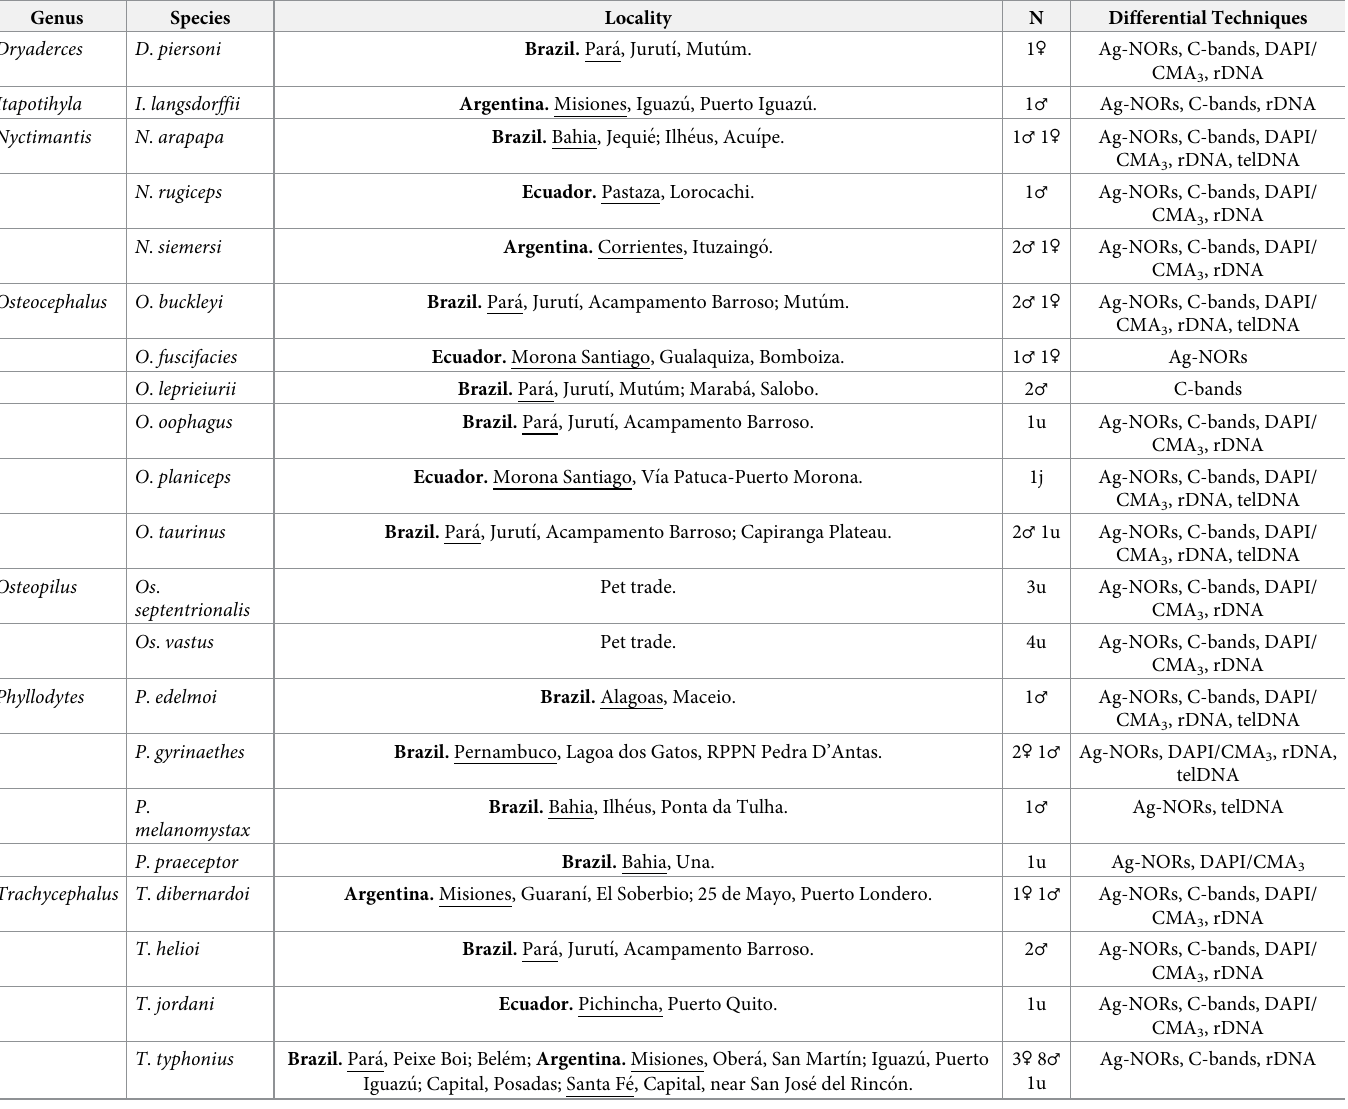
Table 1. Studied species and the cytogenetic techniques applied for each